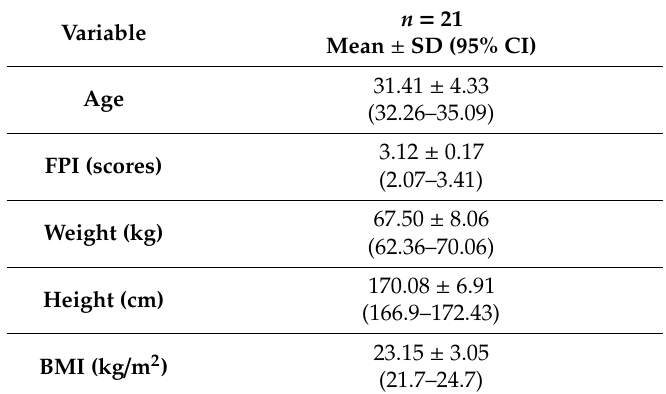
Figure 4. Participant flow chart. Table 1. Participant demographics.